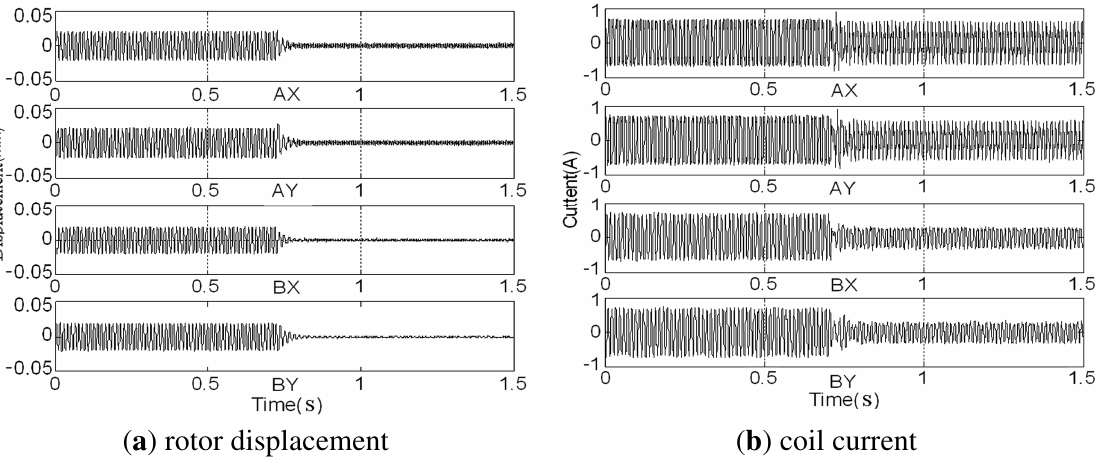
Figure 17. Sensor outputs before and after adding the GPF at 80